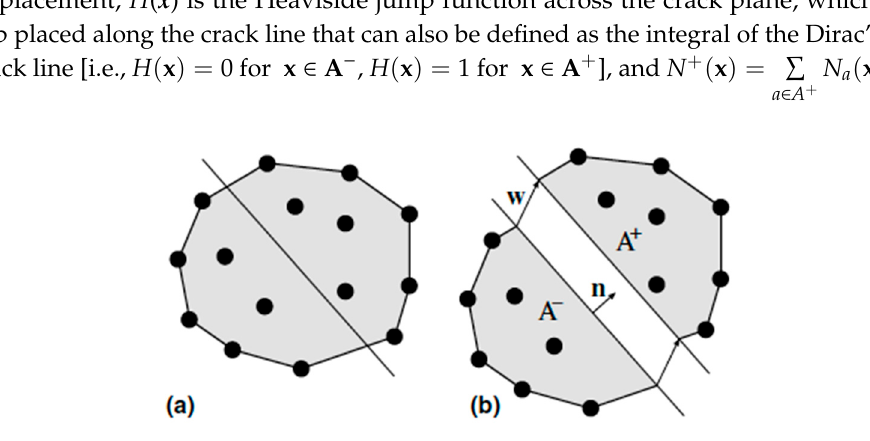
Figure 2. ( a ) Generic element with nodes and crack line and ( b ) displacement jump across the crack line boasting a crack with uniform opening.